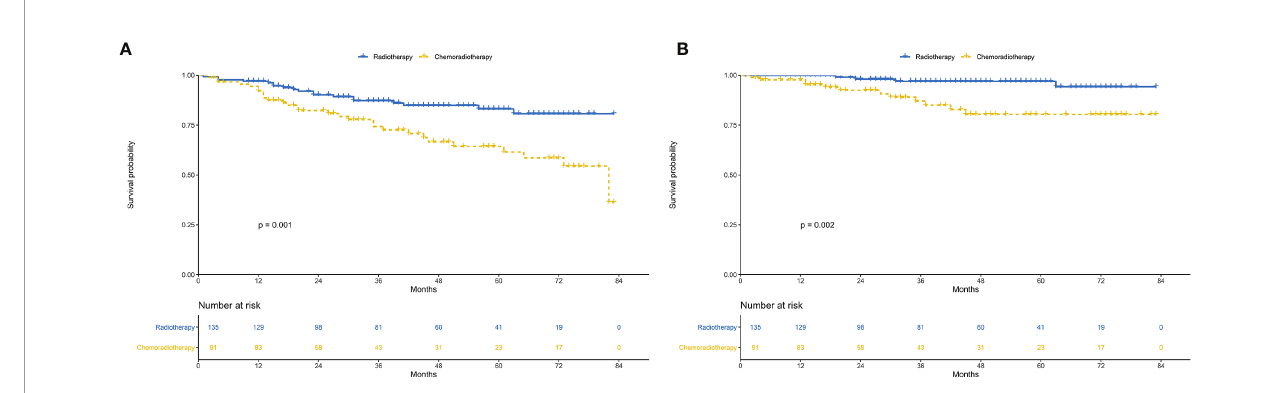
FIGURE 3 | Survival between chemoradiotherapy and radiotherapy groups in the unmatched cohort. (A) Overall survival. (B) Cancer-speci fi c survival.